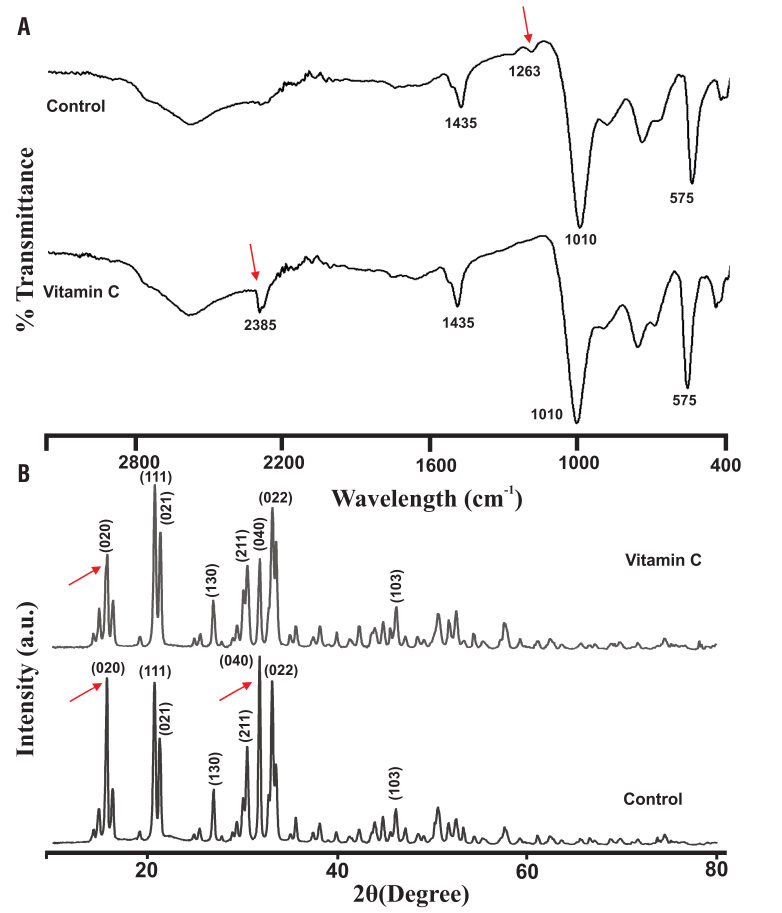
Figure 5 - Representative (a) FTIR and (b) XRD patterns of the of the grown struvite crystal. Arrow indicates differences in the